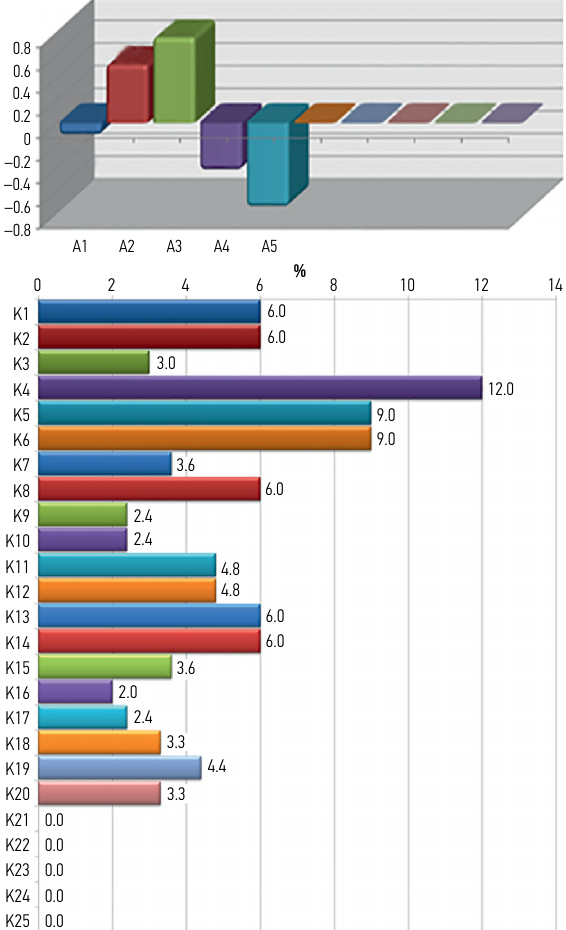
Fig. 7. Analysis of influence of moving weights on the results